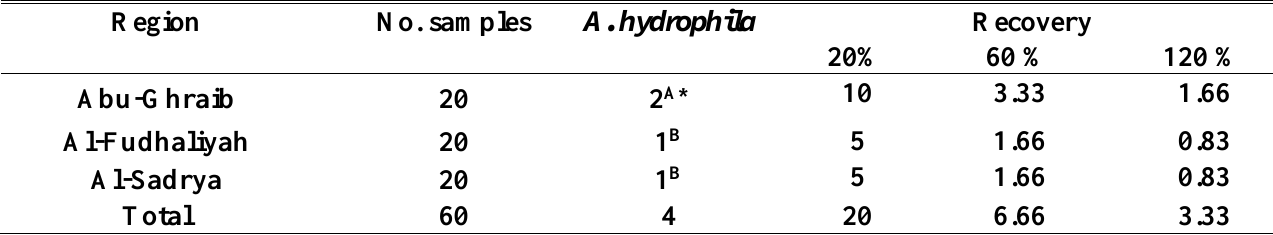
* Indicate highest recovery from Abu-Ghraib. A-B Indicate significant differences vertically among regions at level P≤0.05.